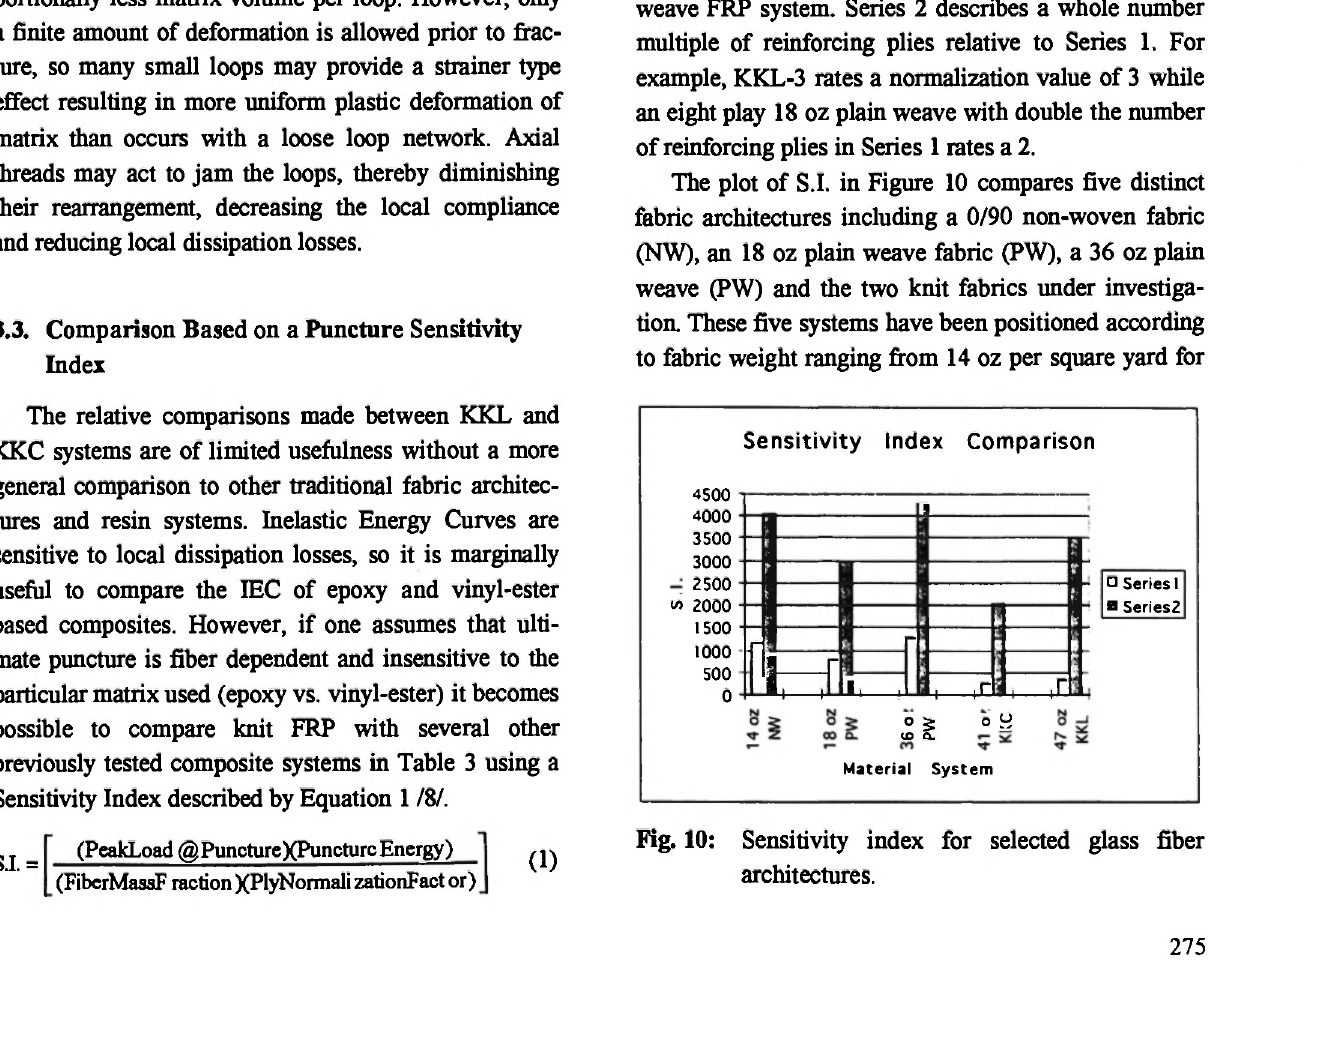
Fig. 10: Sensitivity index for selected glass fiber